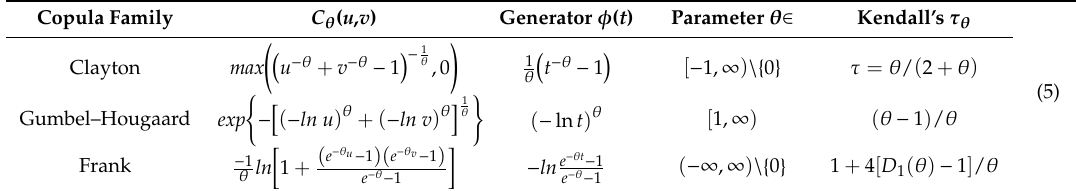
Table 3. Copula function, parameter space, generating function 𝜙 ( t ), and functional relationship of Kendall’s τ θ with a copula parameter for selected single-parameter bivariate Archimedean copulas. Copula Family